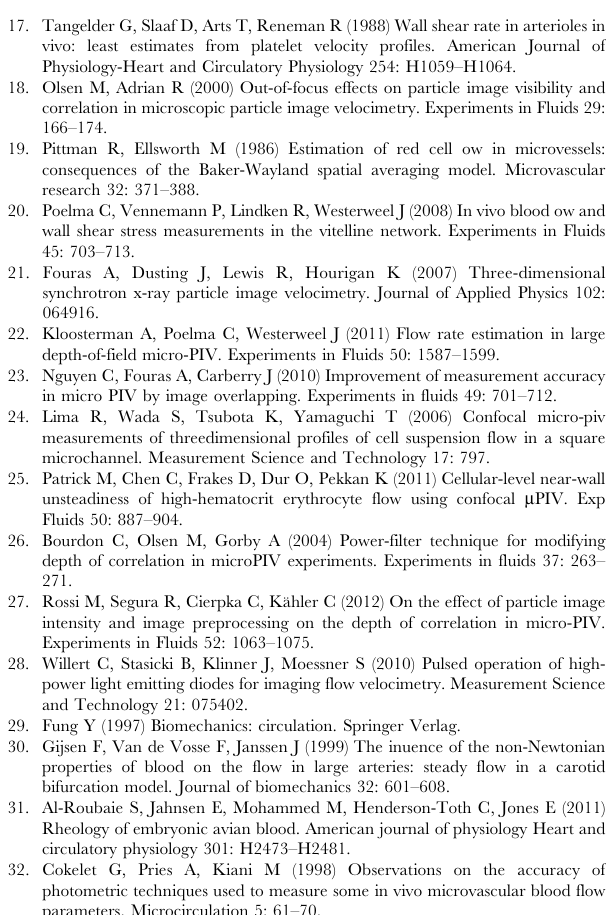
Figure S3 In silico PIV model: summation of the correlation function to predict underestimation. Individ- ual displaced correlation functions and their sum (arbitrarily scaled in the vertical direction). Two individual contributions are labeled as ‘A’ and ‘B’, representing out-of-focus (near wall) and in-focus (centerline) results, respectively. Figure S4 Prediction for the underestimation based on the ‘in silico’ PIV model. Reference data from Kloosterman et al. [22]. The inset shows the predictions for the old spatial averaging